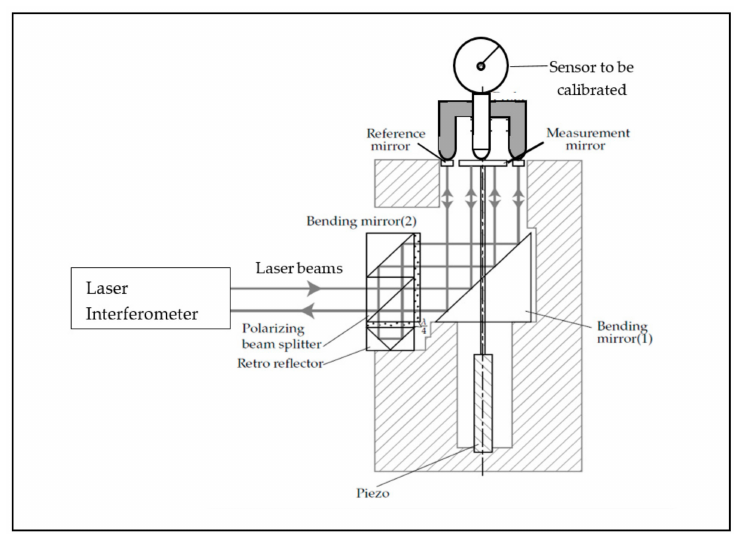
Figure 3. Principle of a sensor calibration system based on a plane mirror laser interferometer. Courtesy of S. Cosijns.